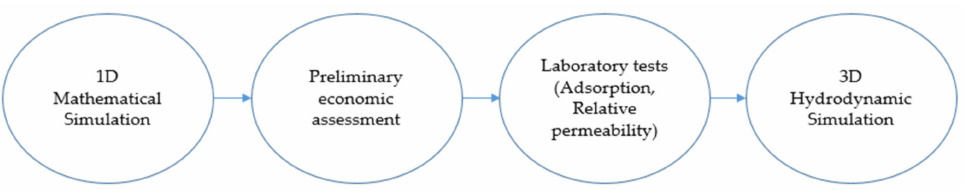
Figure 2. Research methodology